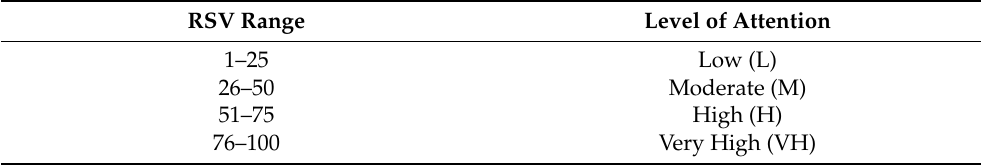
Figure 5. Earthquakes and other natural hazards causing direct rising of GT search interest in earthquake insurance in California; ( upper panel ) worldwide overview, the circles show the earthquakes; the star identifies the Hurricane Harvey landfall in Texas. The dashed box identifies the enlarged area in the figure below; ( lower panel ) California overview. The earthquakes were plotted on the California population density map based on United States Census Bureau for 2010 (https://www.worldofmaps.net/ accessed on 20 February 2022). Table 3. Criteria followed to attribute the level of online attention for earthquake